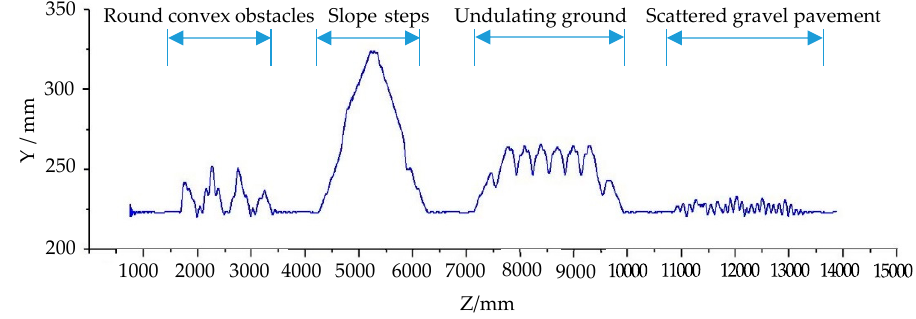
Figure 30. Simulation of the robot passing through the terrain with obstacles presented in Figure 9c: ( a ) passing through round convex obstacles; ( b ) passing through slope steps; ( c ) passing through undulating ground; ( d ) passing through scattered gravel pavement.